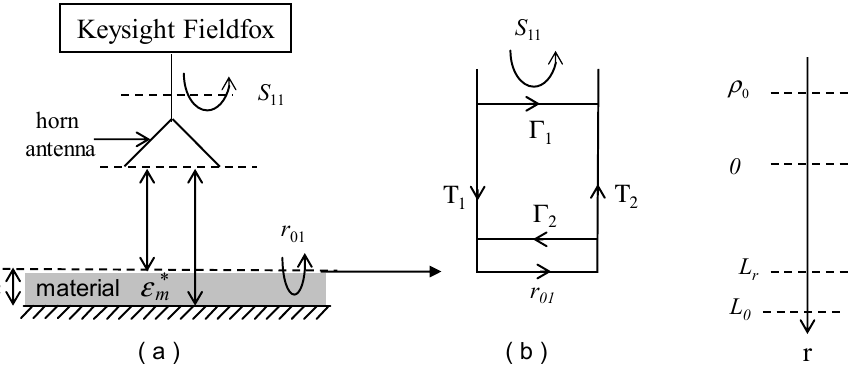
Figure 2. ( a ) Schematic diagram of the free-space monostatic microwave measurement instrumentation. ( b ) Flow-chart of the wave propagation.